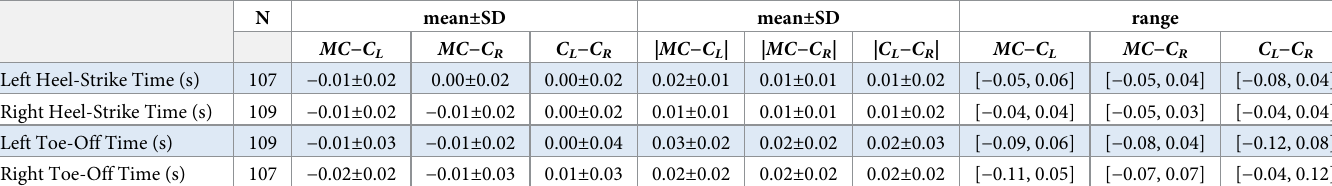
Table 1. Differences in event times for all steps. MC : motion capture; C L : OpenPose left-side view; C R : OpenPose right-side view. Asterisks ( � ) denote P < 0.05.